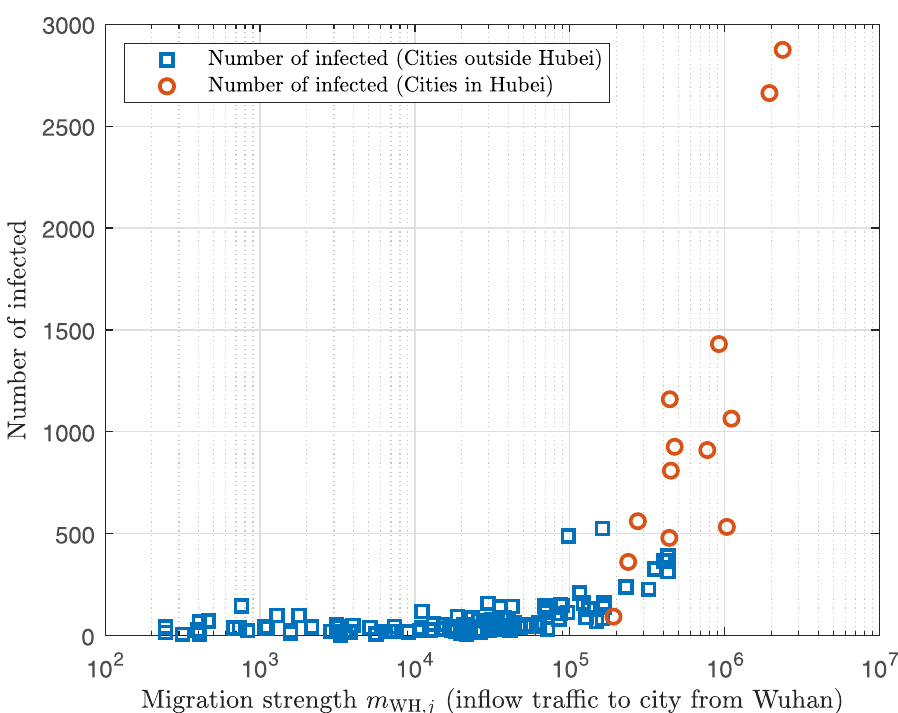
Fig 1. Number of infected individuals in various cities on February 13, 2020 versus the city’s inflow traffic from Wuhan. Inflow traffic of each city from Wuhan is quantified by migration strength from Wuhan extracted from Baidu Migration